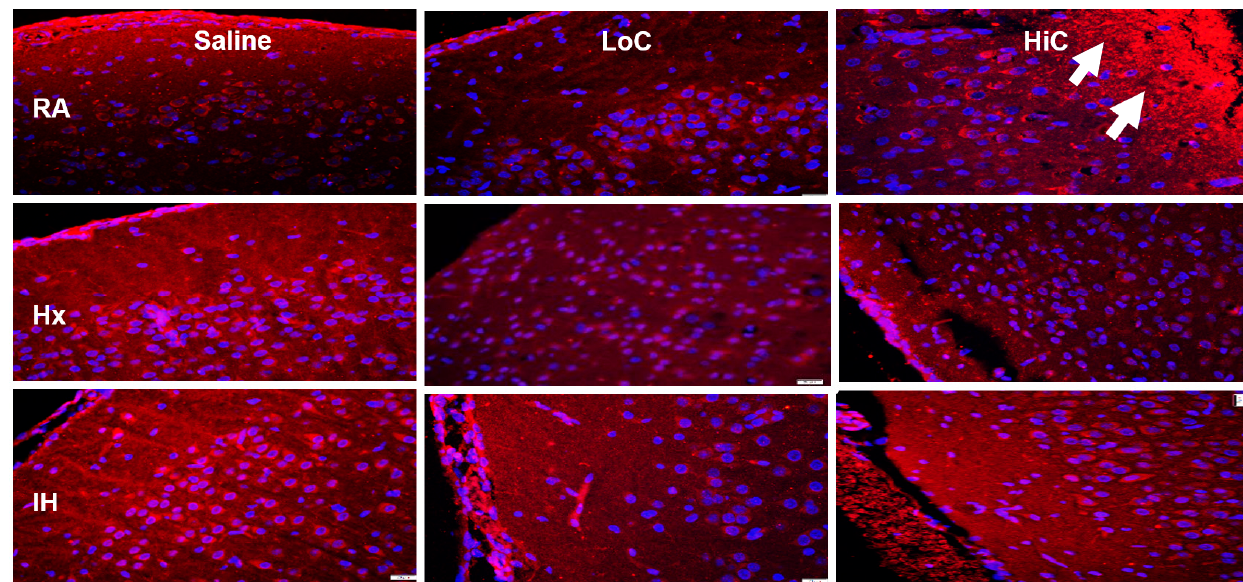
Figure 7. Representative adenosine A1 receptor (A 1 R) immunofluorescence staining in the cerebral cortex at P14. Groups are as described in Figure 2. Images are 20 × magnification, bar scale is 50 µ m. A 1 R was induced in Hx and neonatal IH in the placebo saline groups, and with HiC in RA (arrow).